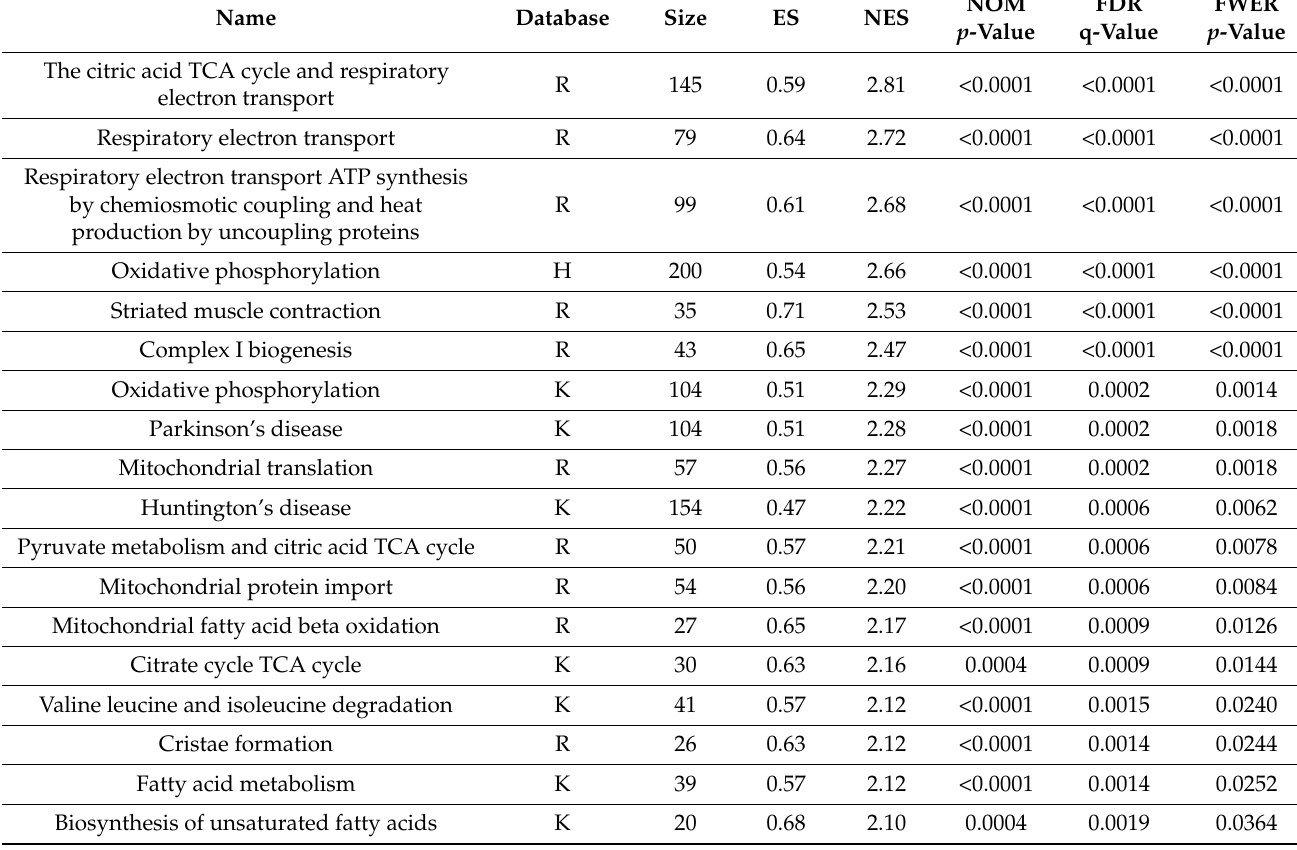
Table 2. Downregulated gene sets in SAT of patients with T2D analysed with